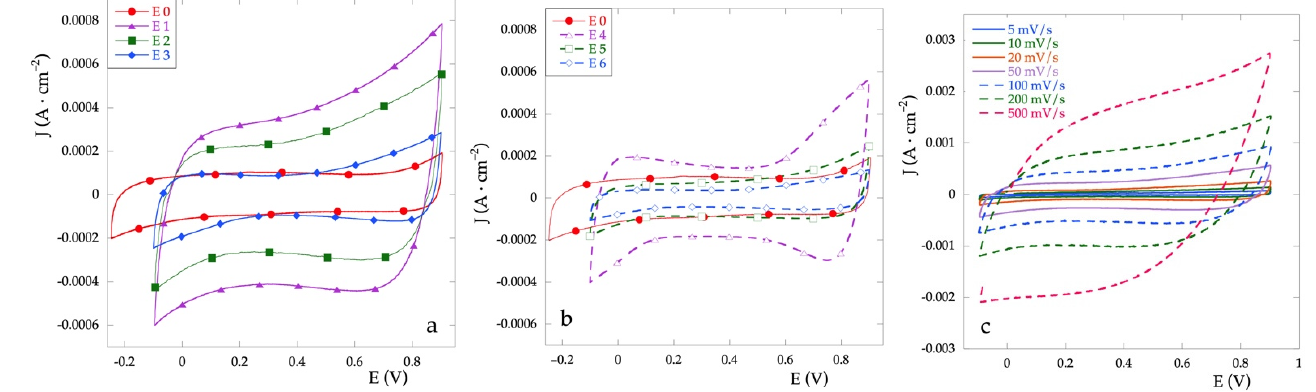
Figure 4. Cyclic voltammetries for Ti \ Ru y Cu 1 − y O x series electrodes ( a ), for Ti \ RuO x \ Ru y Cu 1 − y O x series electrodes ( b ) recorded at v = 50 mV · s − 1 in Na 2 SO 4 0.1 M vs. Ag/AgCl. ( c ) CV for E2 electrode at different scan rate in the same solution.